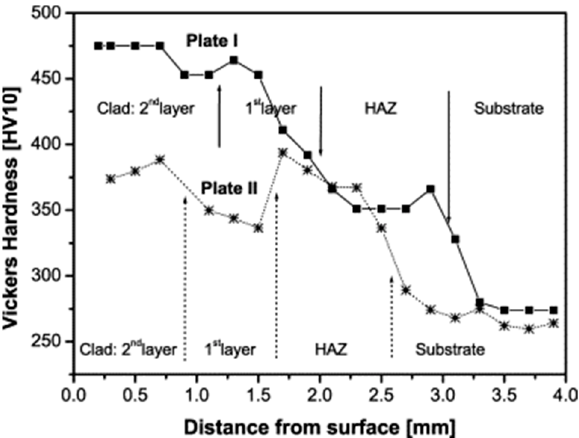
Figure 3. Hardness evolution as a function of the depth below the clad surface for both carbon steel (B 82) plates cladded Co-Cr alloys (Reprinted from Ref. [48], copyright (2004), with permission from Elsevier).